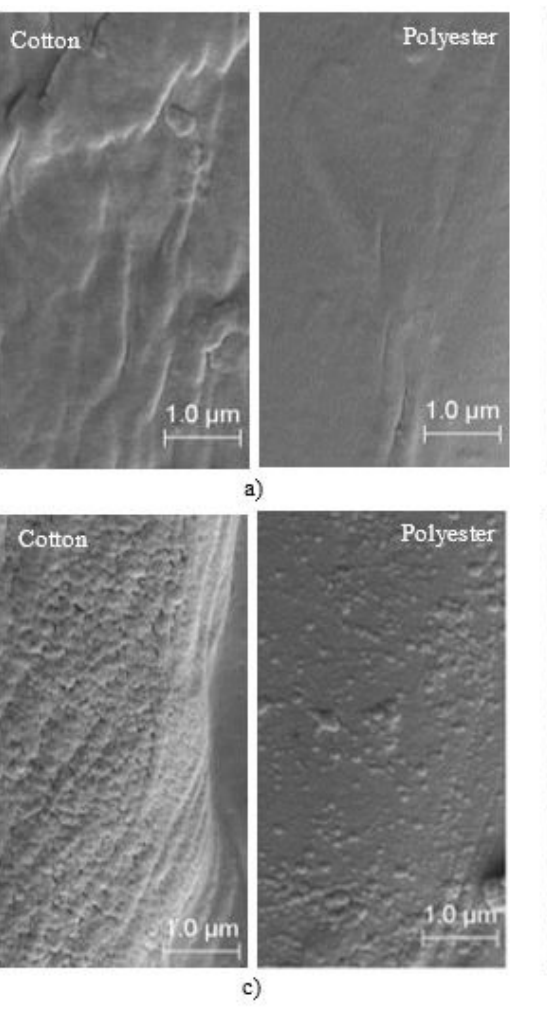
Figure 3. SEM images of untreated (a), argon (b), oxygen (c) and air plasma (d) treated